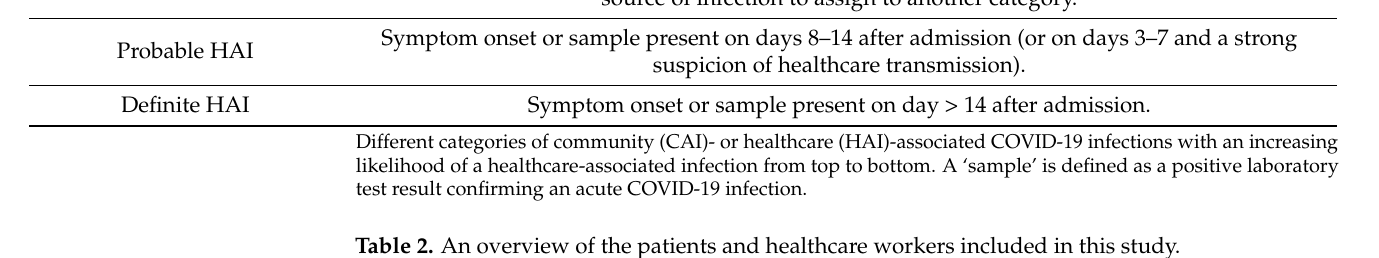
Table 2. An overview of the patients and healthcare workers included in this